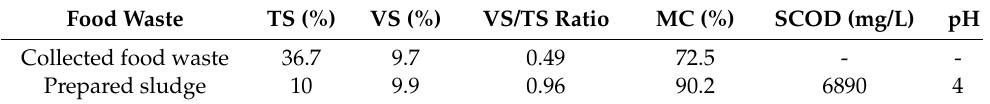
Table 2. Characterization of food